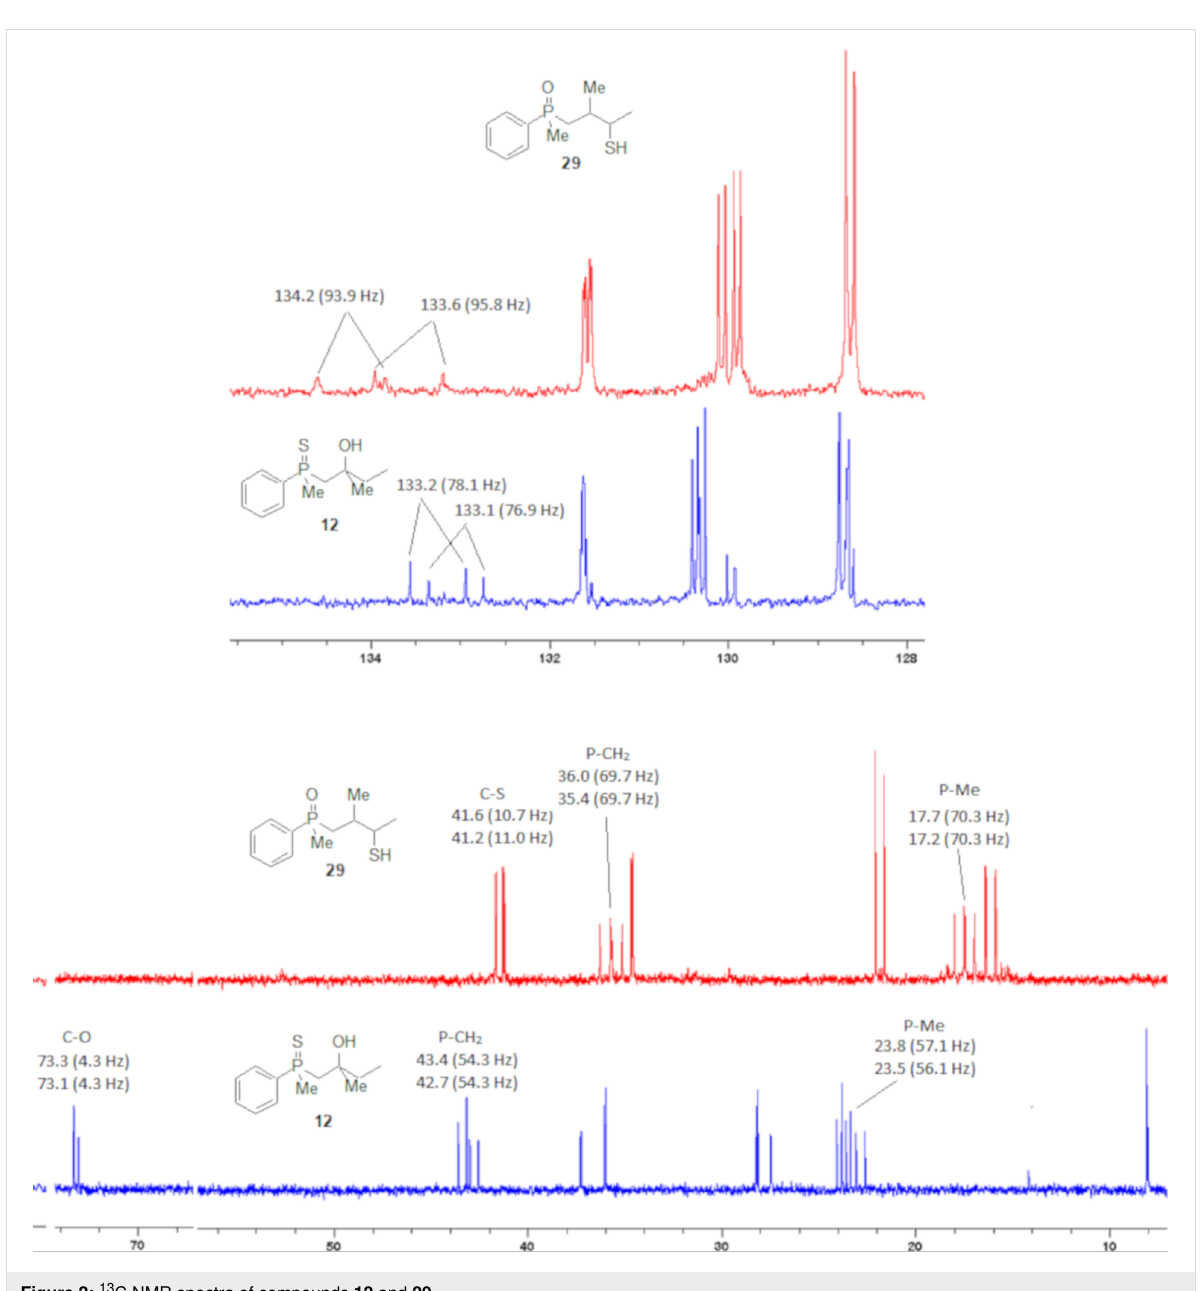
Figure 2: 13 C NMR spectra of compounds 12 and 29